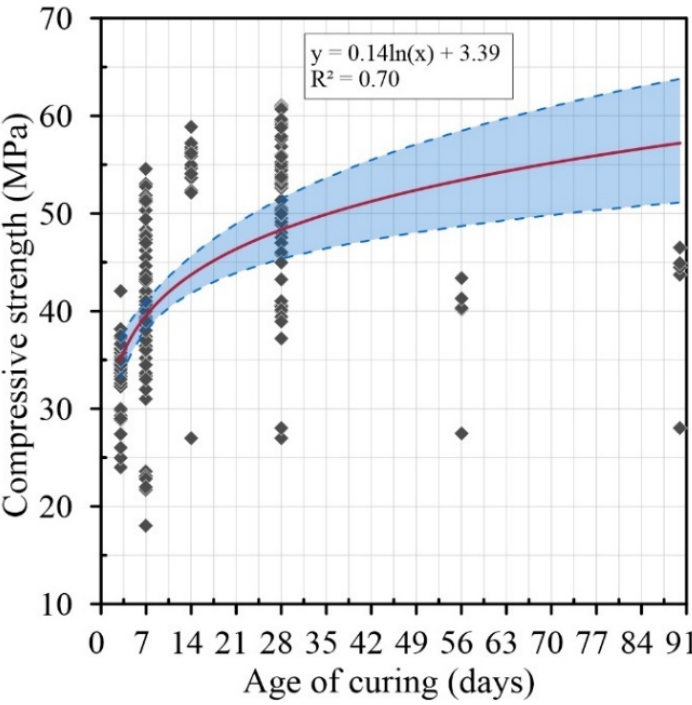
Figure 3. Age of curing (days) versus compressive strength with HCl treatment.